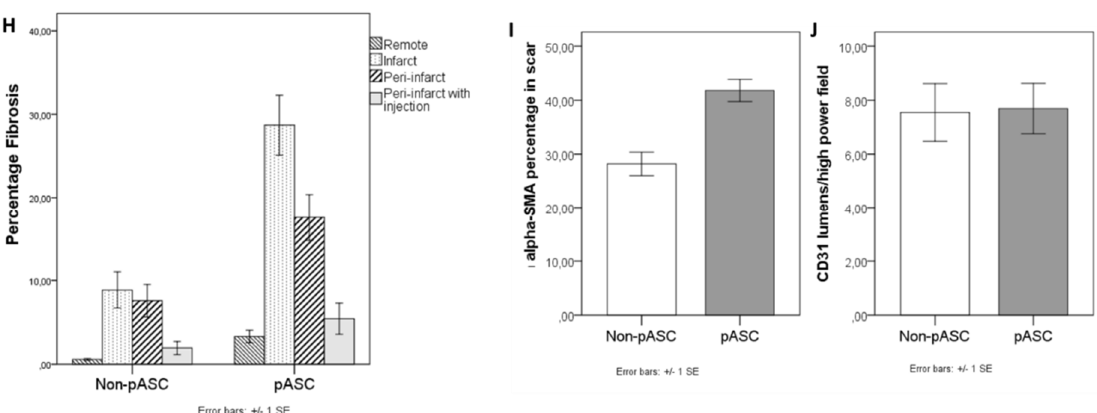
Figure 3. Myocardial histology. ( A ) Representative image of histology sampling from infarcted areas ( B , C , E ); peri-infarcted areas ( D , F , G ); ( B ) Masson’s Trichrome × 1.25 ( C ) Hematoxylin-eosin × 5 ( D ) Integrin α v β 3 × 20 ( E ) α -smooth muscle actin × 20 ( F ) CD68 × 20 ( G ) CD31 × 20 ( H ) Percentage fibrosis in all sample areas (I) α -smooth muscle actin percentage in scar ( J ) CD31 vessel density per high power field. pASC: porcine adipose-derived stromal cells in alginate hydrogel, Arrows show co-localization of integrin α v β 3 and CD31.